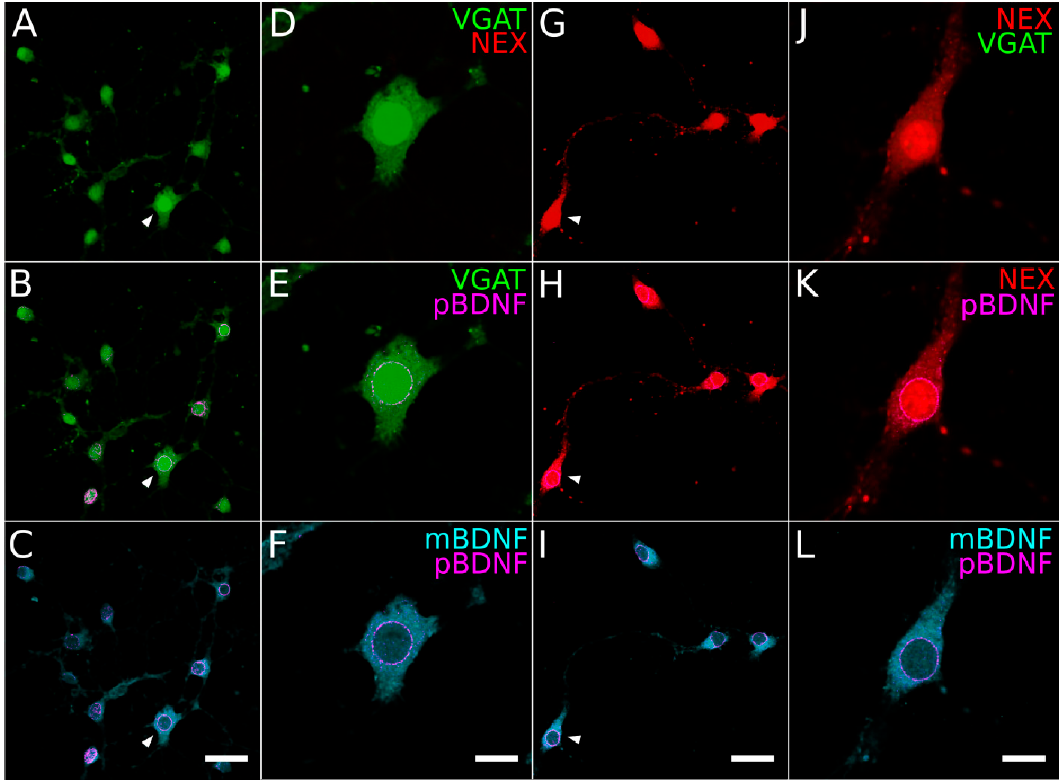
Figure 6. Expression of mBDNF and proBDNF in purified cortical neuron cultures. Immunostaining